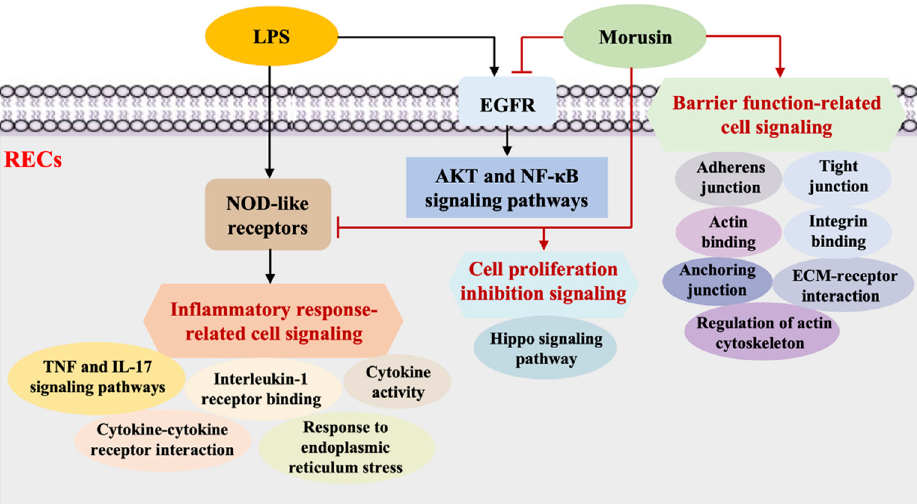
Figure 8. Schematic diagram summarizing the regulatory mechanisms underlying the protective effects of Morusin against lipopolysaccharide (LPS)-induced inflammation in ruminal epithelial cells (RECs). Morusin suppressed the inflammatory-response-related signaling, while it promoted the cell-proliferation-inhibition- and barrier-function-related cell signaling in RECs upon LPS stimulation. Specifically, the pretreatment with Morusin inhibited AKT and NF- κ B signaling in RECs upon LPS stimulation by inhibiting EGFR signaling. The arrow represents activation, and the inverted-T represents inhibition.